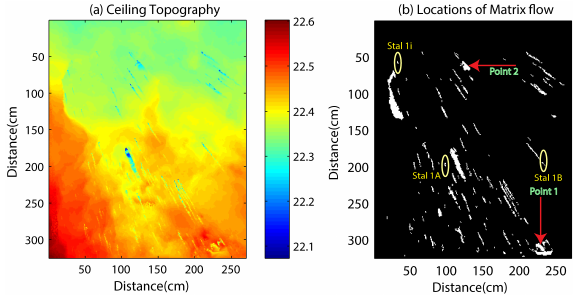
Figure 5. Morphological analysis of the cave ceiling portion con- sisting of sites 1ii, 1iii, and 1v to identify different flow patterns (icicle, soda straw, fracture, and combined). (a) Cave ceiling topog- raphy in 2-D. Colour scales represent elevations in metres relative to the T-LiDAR receiver. (b) Stalactites categorized as icicle flow pattern. (b) Stalactite 1v categorized as soda straw (Mahmud et al.,